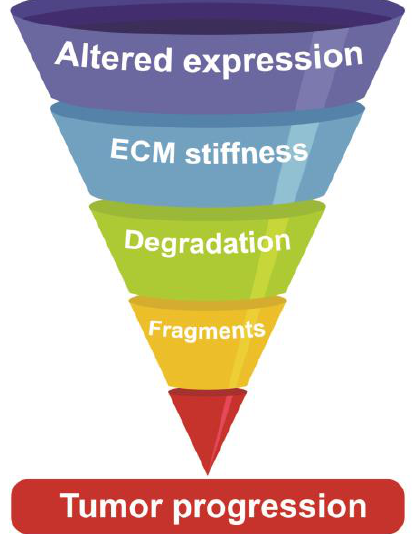
Figure 3. Schematic representation of the mechanisms by which the ECM affects tumor progression. In the TME, the ECM composition is modified due to altered expression of ECM molecules, mainly mediated by CAFs, and to the formation of inter- and intra-molecular crosslinking resulting in increased tissue stiffness. Furthermore, the higher levels of proteolytic enzymes lead to increased ECM degradation and the release of biologically active fragments/growth factors.